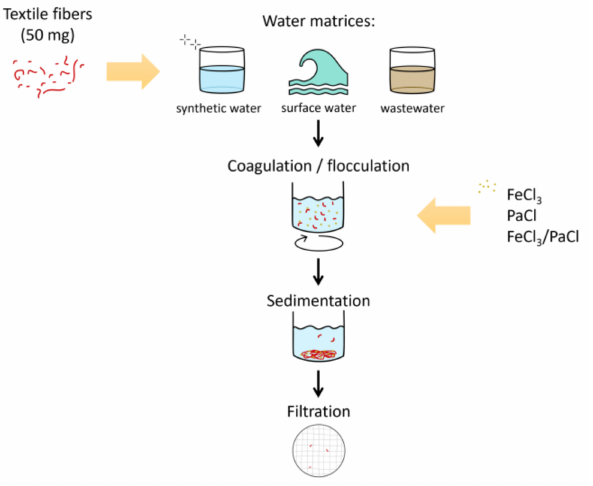
Figure 1. Schematic representation of the